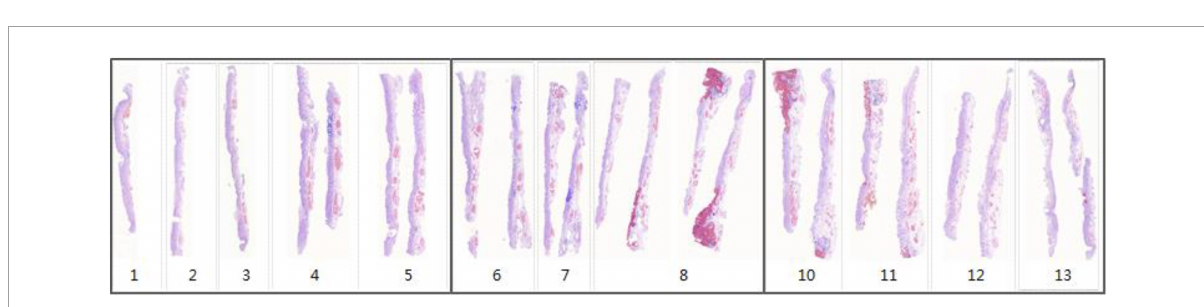
FIGURE7 Whole slide image-level thumbnail results of 13 ESD specimens. Blue mark: Intestinal metaplasia. Red mark: Cancerous.